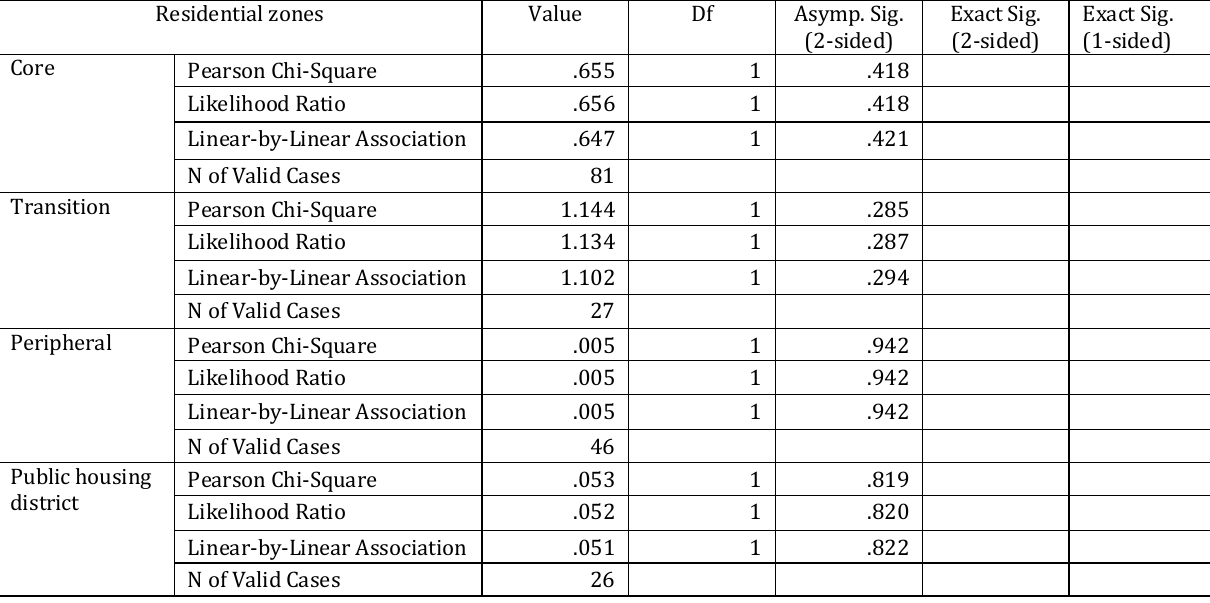
Table 6. Chi-Square summary for providers of toilet facilities across residential